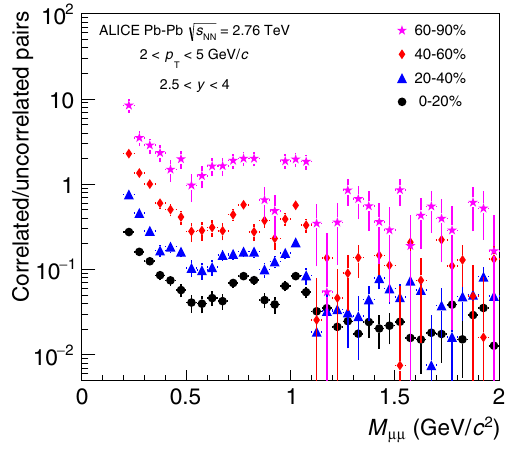
Fig. 2 Ratio between the mass spectra of correlated and uncorrelated pairs for different centralities, in the range 2 < p T < 5 GeV/c in Pb–Pb √ s NN = 2 . 76 collisions at